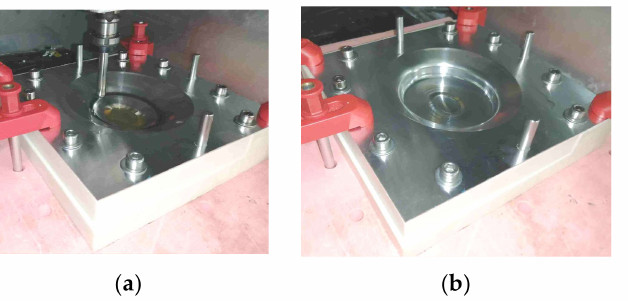
Figure 29. The proposed forming method: ( a ) the second-stage forming process; ( b ) the part formed by the second-stage forming.